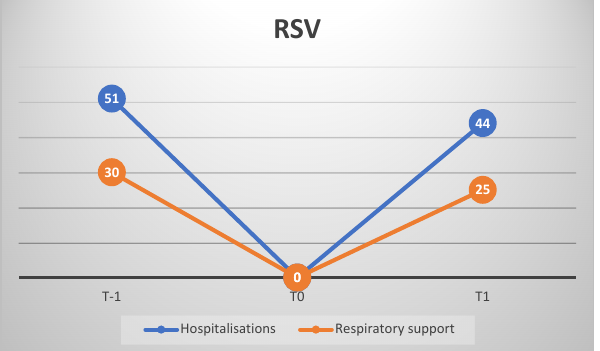
Figure 1. Hospitalized patients for RSV ‐ mediated bronchiolitis (blue line) and patients who needed respiratory support (orange line). T ‐ 1: 2018–2019; T0 2020 lockdown; T1: 2020 post ‐ lockdown and 2021.